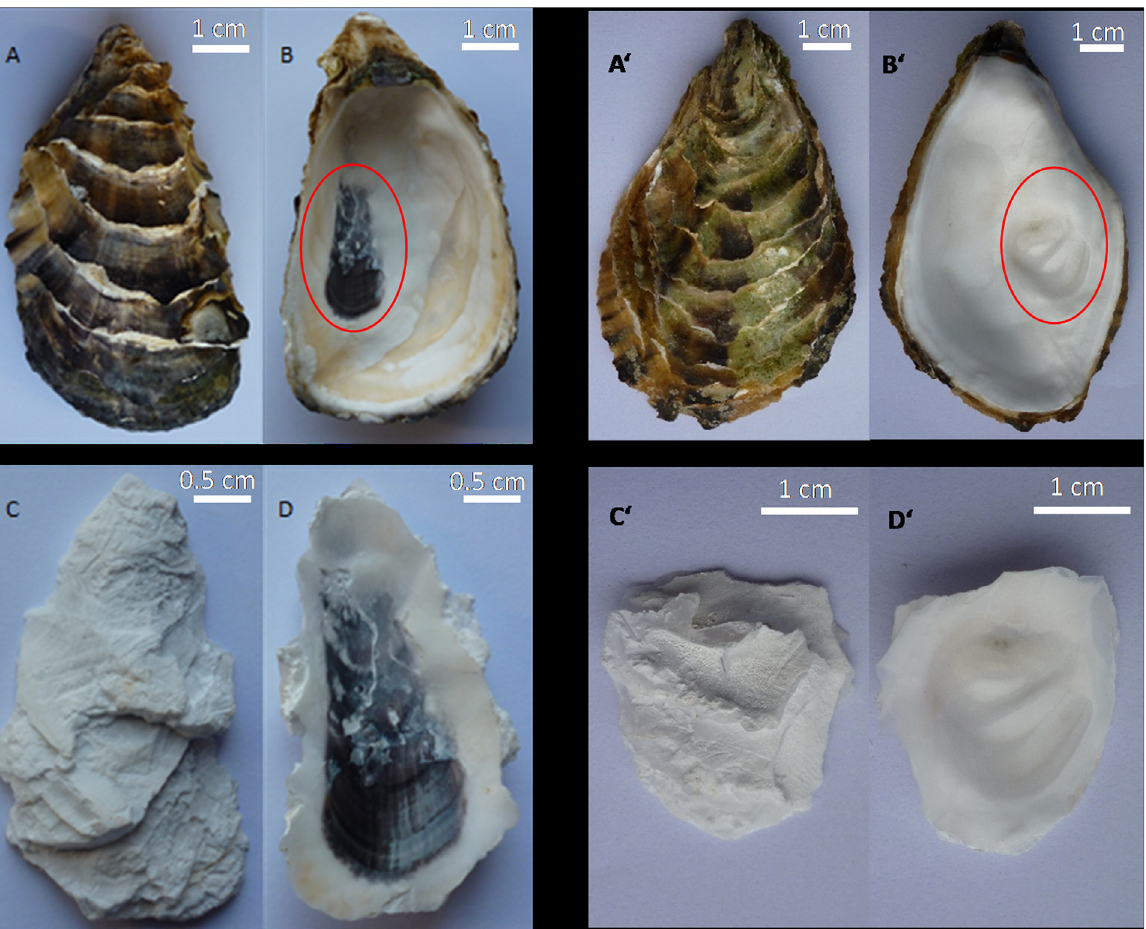
Fig 1. The pigmented and nonpigmented adductor muscle scars of Pacific oyster. Panel A, the outside surface of the untreated shell with pigmented adductor muscle scar; panel B, the inside surface of the untreated shell with pigmented adductor muscle scar; panel C, the outside surface of the pigmented adductor muscle scar region following treatment; panel D, the inside surface of the pigmented adductor muscle scar region following treatment; panel A ’ , the outside surface of the untreated shell with nonpigmented adductor muscle scar; panel B ’ , the inside surface of the untreated shell with nonpigmented adductor muscle scar; panel C ’ , the outside surface of the nonpigmented adductor muscle scar region following treatment; panel D ’ , the inside surface of the nonpigmented adductor muscle scar region following